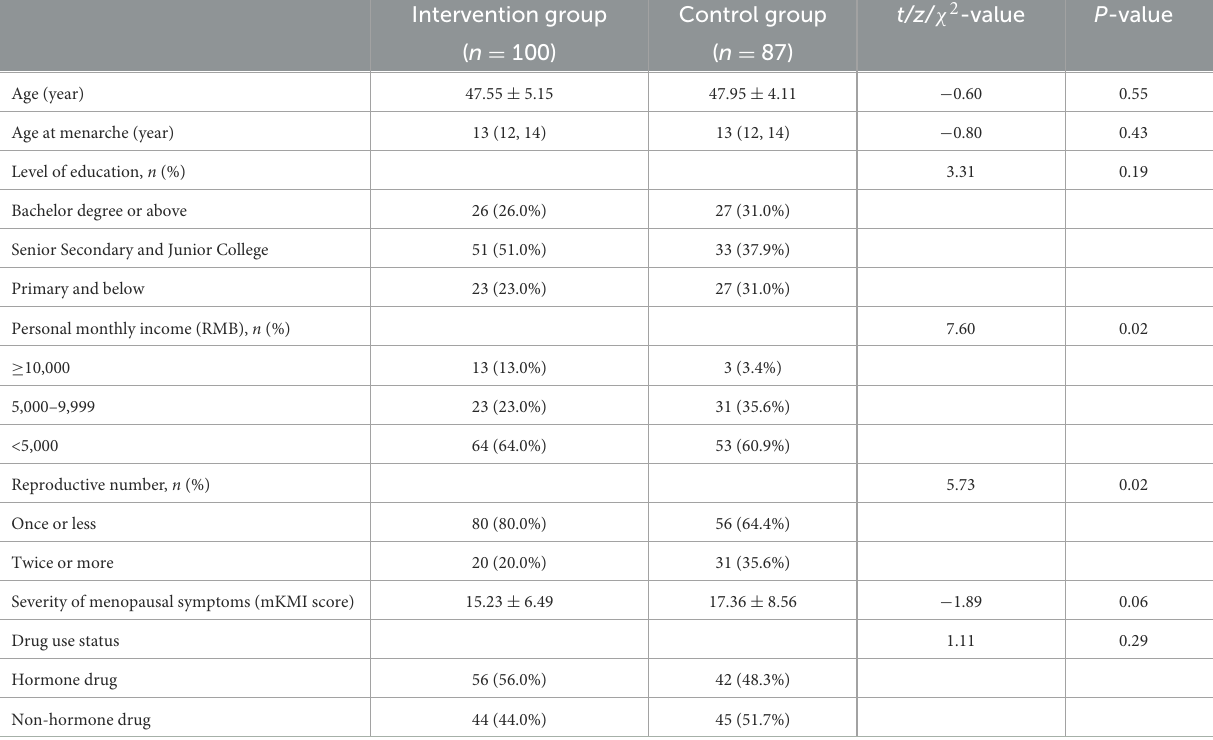
TABLE 1 Comparison of the baseline characteristics between groups.